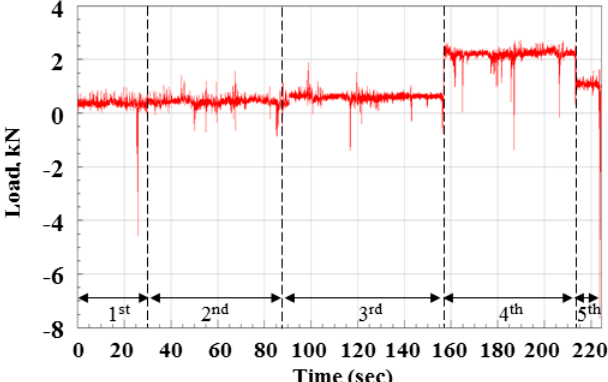
Figure 7. Load amplitude history for disk harrow assembly. Table 2. Principal direction of disk harrow assembly.